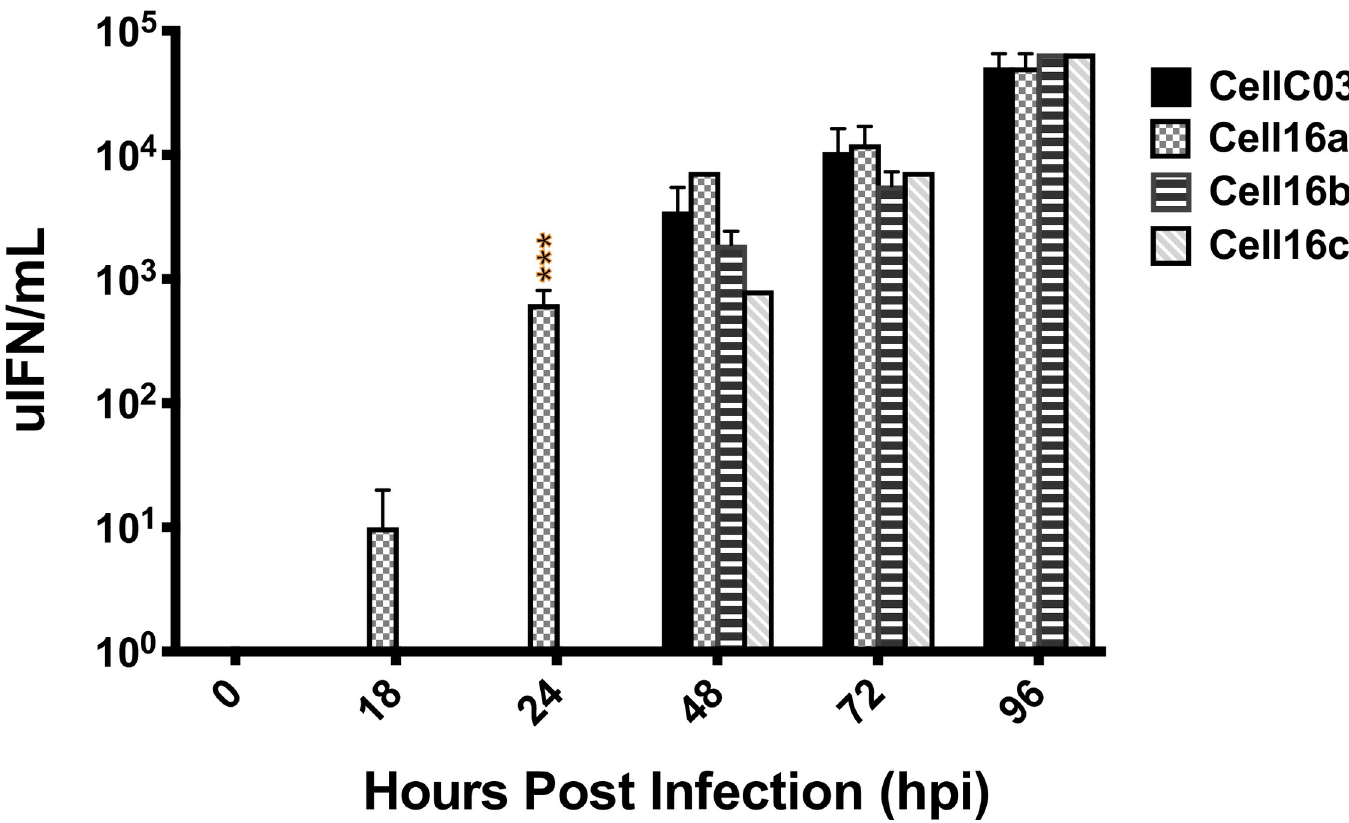
Fig 7. Antiviral assay comparison of host IFN suppression between reference (CellC03) and three more recent VHSV-IVb isolates, in EPC cells 96 hpi following exposure to UV irradiated media collected at the above time points. Values are quantified as the number of antiviral units (uIFN) per ml. Standard error bars are representative of at least three independent experimental replicates (some are too small to visualize). Statistical significance is shown: � p < 0.05; �� p < 0.01; ��� p < 0.001.